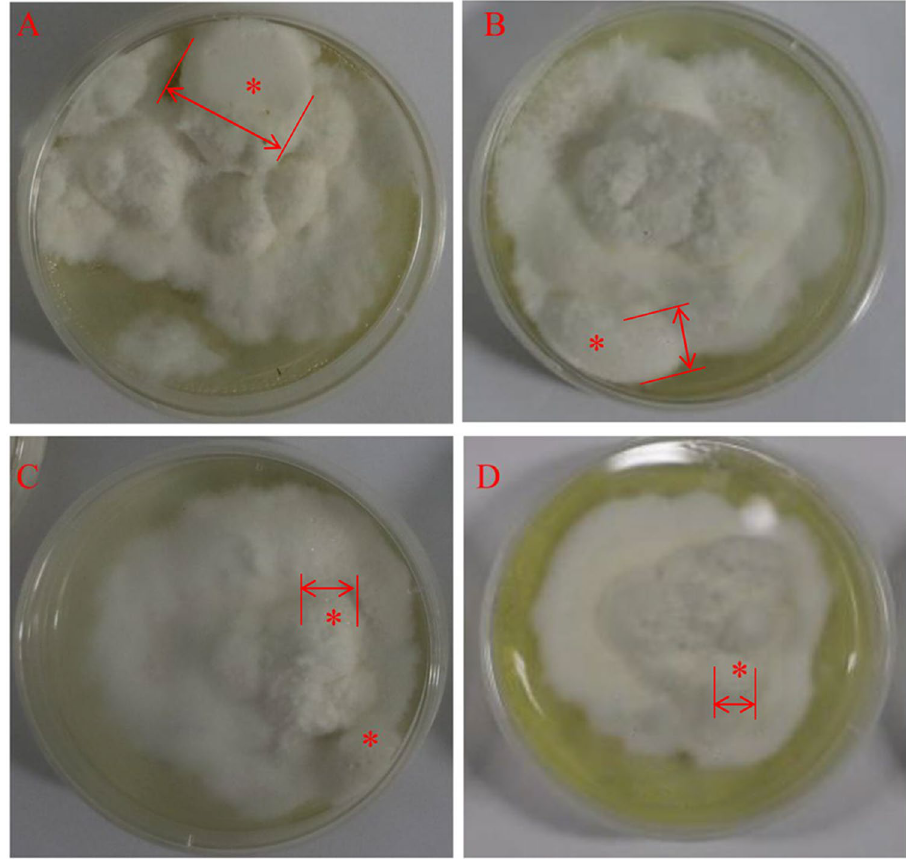
Figure 5. Growth characteristics of mycelia and sclerotia of P. umbellatus under extra treatment. ( A ) P. umbellatus cultured on basic medium. Sclerotia and hypha were inhibited by NADPH oxidase inhibitor DPI ( B ) and sirt1720 hydrochloride as SIRT1 inhibitor ( C ). DPI and sirt1720 hydrochloride exhibited a synergistic role in restraining P. umbellatus ( D ). Red asterisks represent sclerotium, and the boundary of sclerotium was marked by red double arrow.